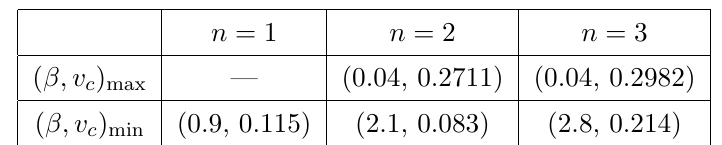
Figure 4 . The root-mean-square error (cid:14)E rms as a function of the spatial step size, or equivalently, the number of collocation points N . The tolerance option of the ode45 solver is set as RelTol= 10 (cid:0) 11 and AbsTol= 10 (cid:0) 13 .